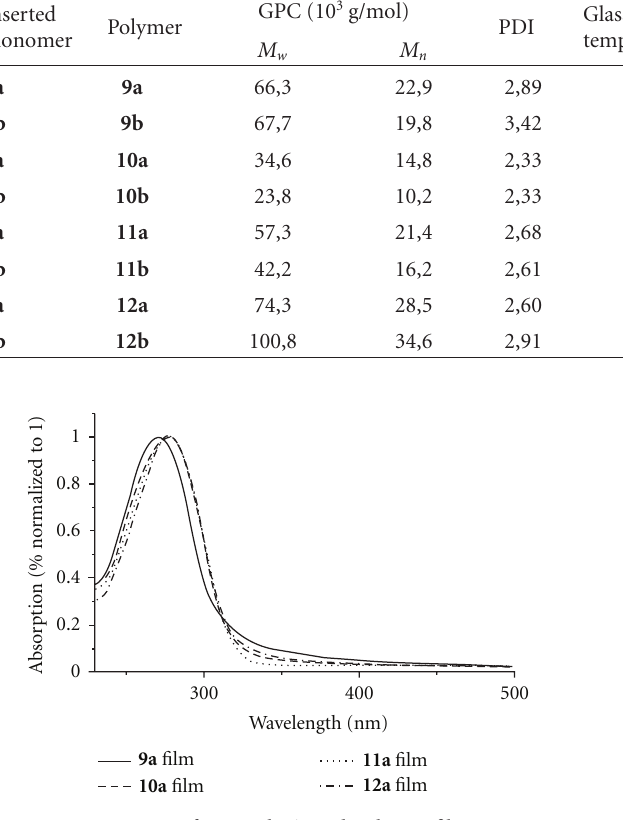
Figure 4: UV-spectra of metasubstituted polymer films 9a – 12a on silica glass.